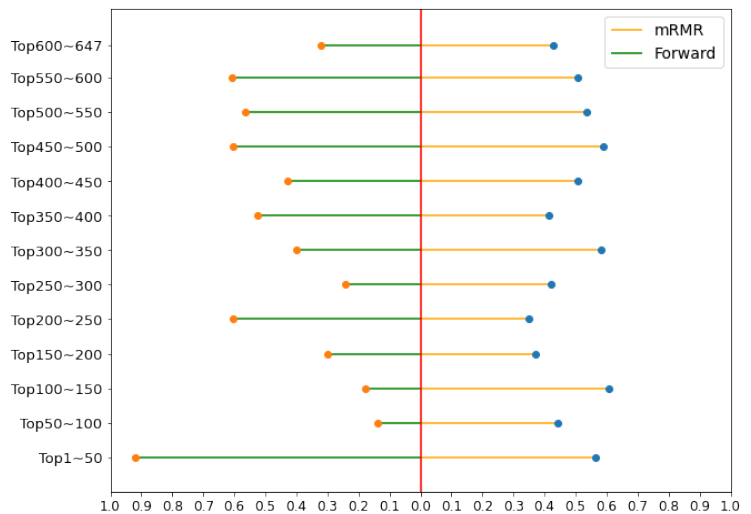
Figure 3. Feature importance analysis of the mRMR method and the forward feature searching strategy. The dots of the Spearman’s coefficient are produced using the mRMR features (orange lines, blue dots) and the forward feature searching strategy (green lines, orange dots). The first 50 features of the forward feature searching method achieved the highest